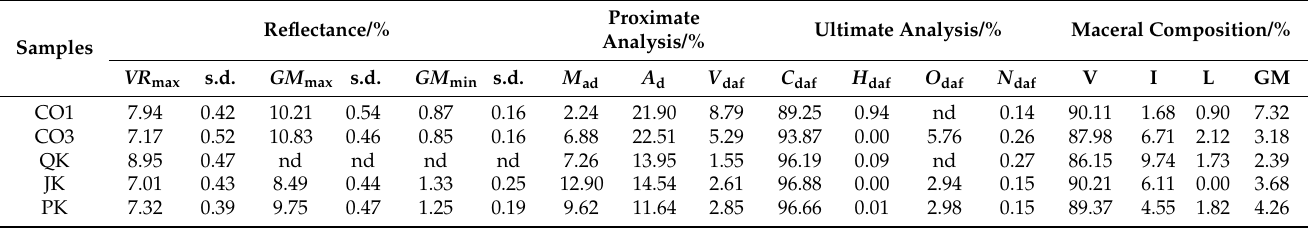
Table 1. Basic properties of graphitized coal samples in the Yongan